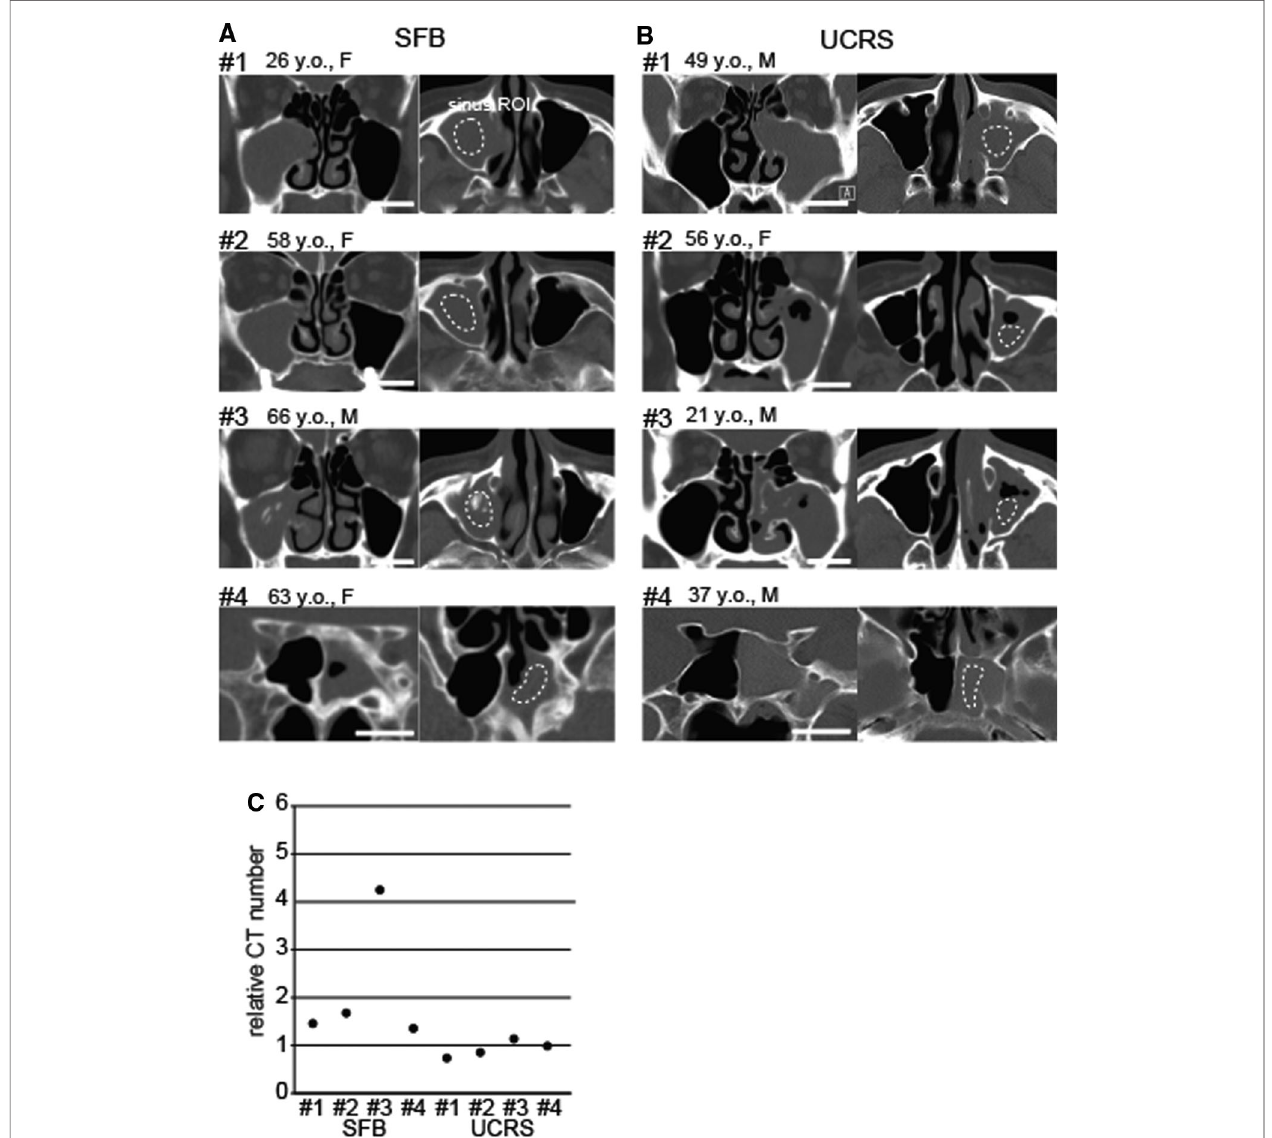
FIGURE 1 | Representative images of sinus fungal ball (SFB) and unilateral nonfungal chronic sinusitis (UCRS), ( A ) CT images of SFB cases (#1 – #4). ROIs were de fi ned in the affected sinus (dotted circle), and the brainstem was used as a control area. ROI, region of interest. Scale bar, 20 mm. ( B ) CT images of UCRS cases (#1 – #4). ROIs were de fi ned in the affected sinus (dotted circle), and the brainstem was used as a control area. Scale bar, 20 mm. ( C ) Relative CT numbers in SFB and UCRS cases. Each dot represents the relative CT number of an individual case.